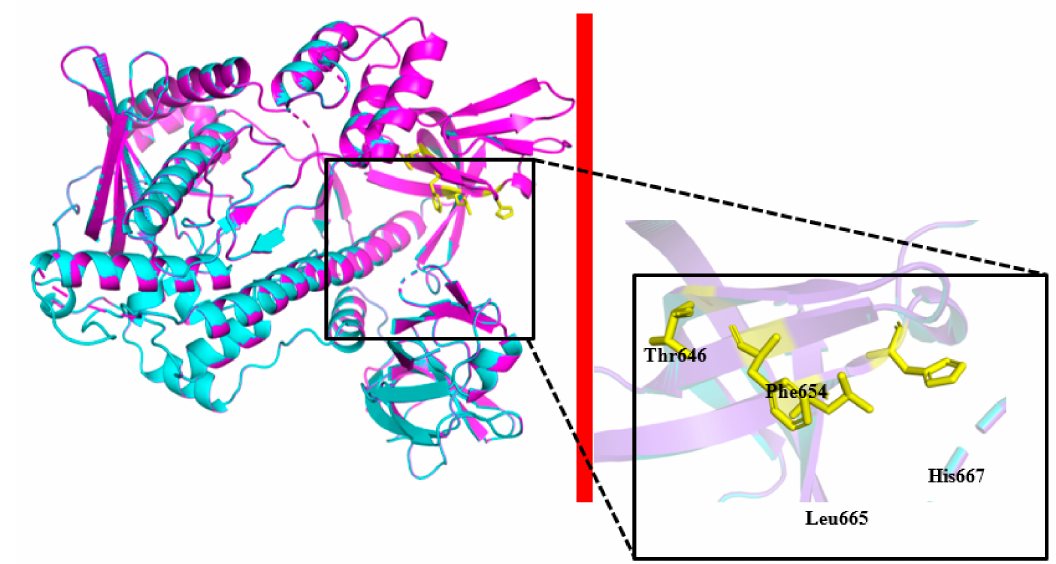
Figure 2. The 3D structure models of PsRNR and structure superimposition with EcRNase R (PDB ID: 5XGU). The catalytic triad residues are indicated as stick models.